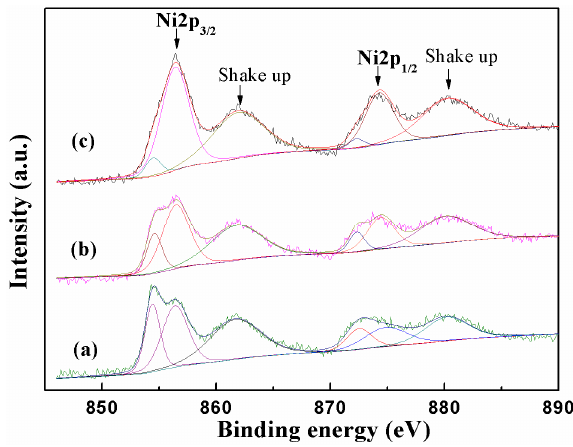
Figure 4. Ni ‐ 2p region of the XPS spectra of various samples without reduction (20 wt % Ni loading): ( a ) Ni/M 0EG; ( b ) Ni/M 1EG and ( c ) Ni/M(H) 1EG.